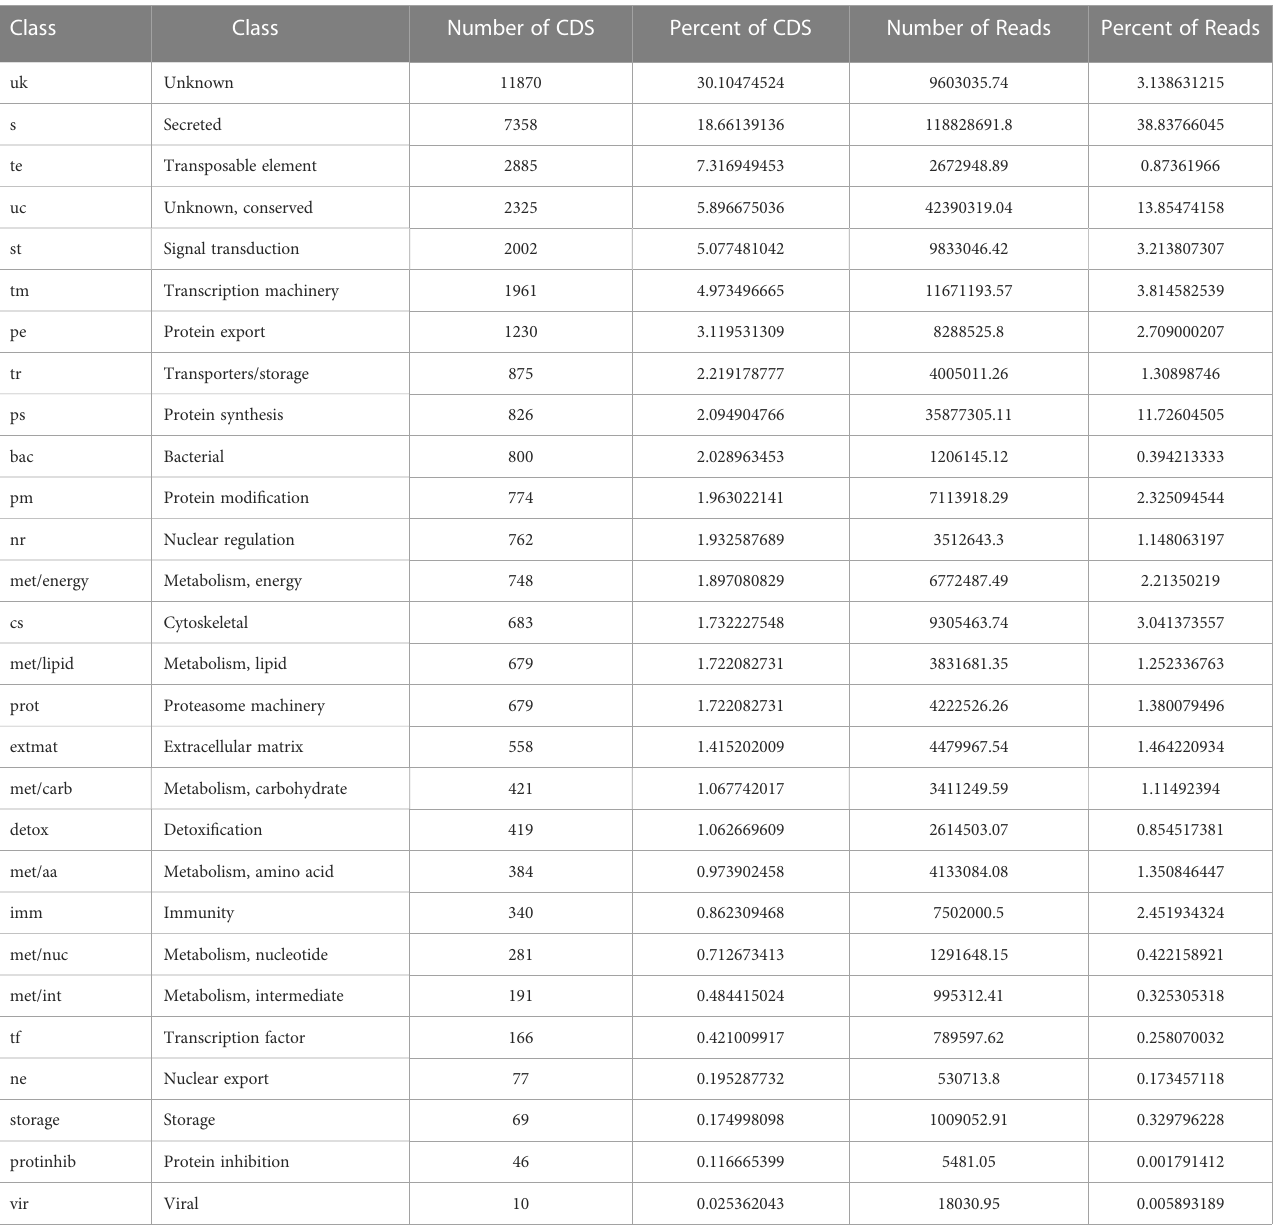
TABLE 1 Functional categories of all differentially expressed coding